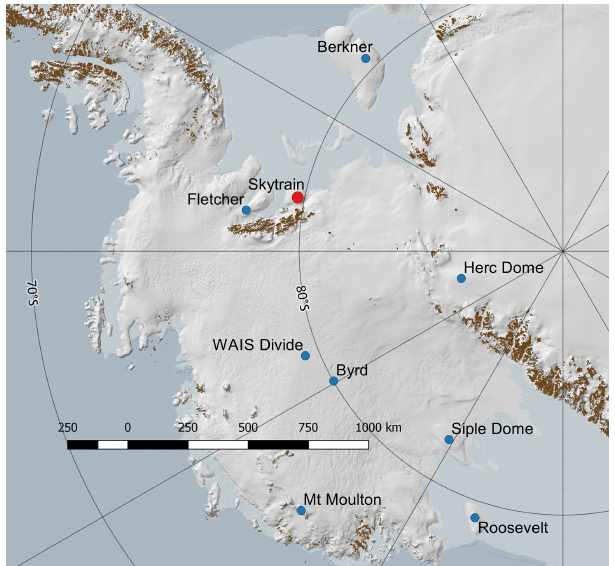
Figure 1. Map showing ice core sites in West Antarctica that are mentioned in the text. Map generated using QGIS with the Quantarctica mapping environment (Matsuoka et al., 2021).